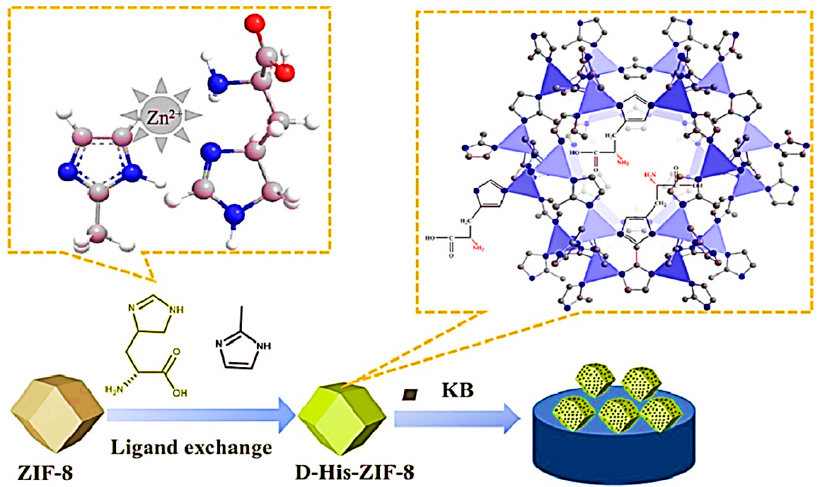
Figure 9. Scheme of the fabrication of D-His-ZIF-8-based enantioselective electrochemical sensing platform. Reprinted (adapted) with permission from [90].